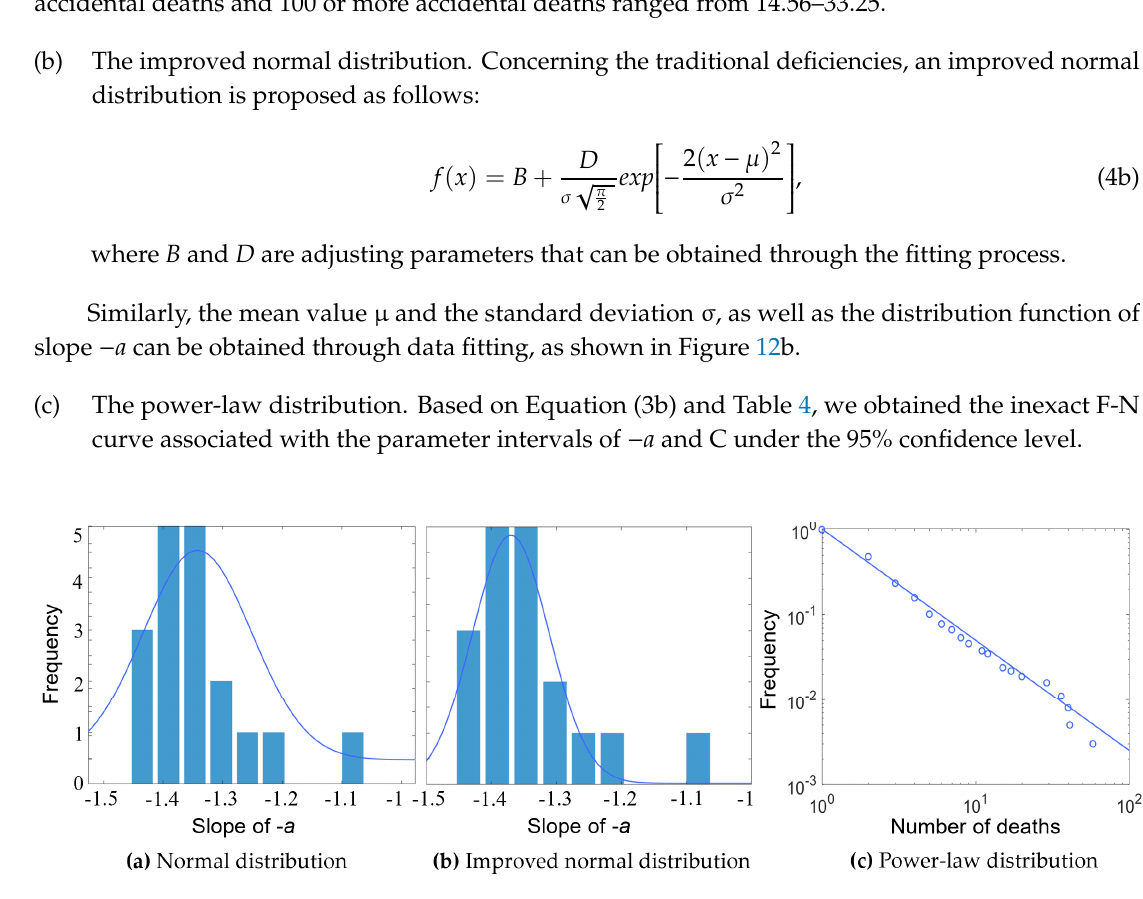
Figure 12. F-N curves (i.e., the relationship between the cumulative probability F and the number of deaths N ) fitting based on di ff erent distributions. ( a , b ) demonstrate the frequency distribution histogram of slope − a fitting under the normal distribution and the improved normal distribution, respectively. ( c ) is the F-N curve of deaths and cumulative probability under the power-law distribution in the logarithmic coordinate